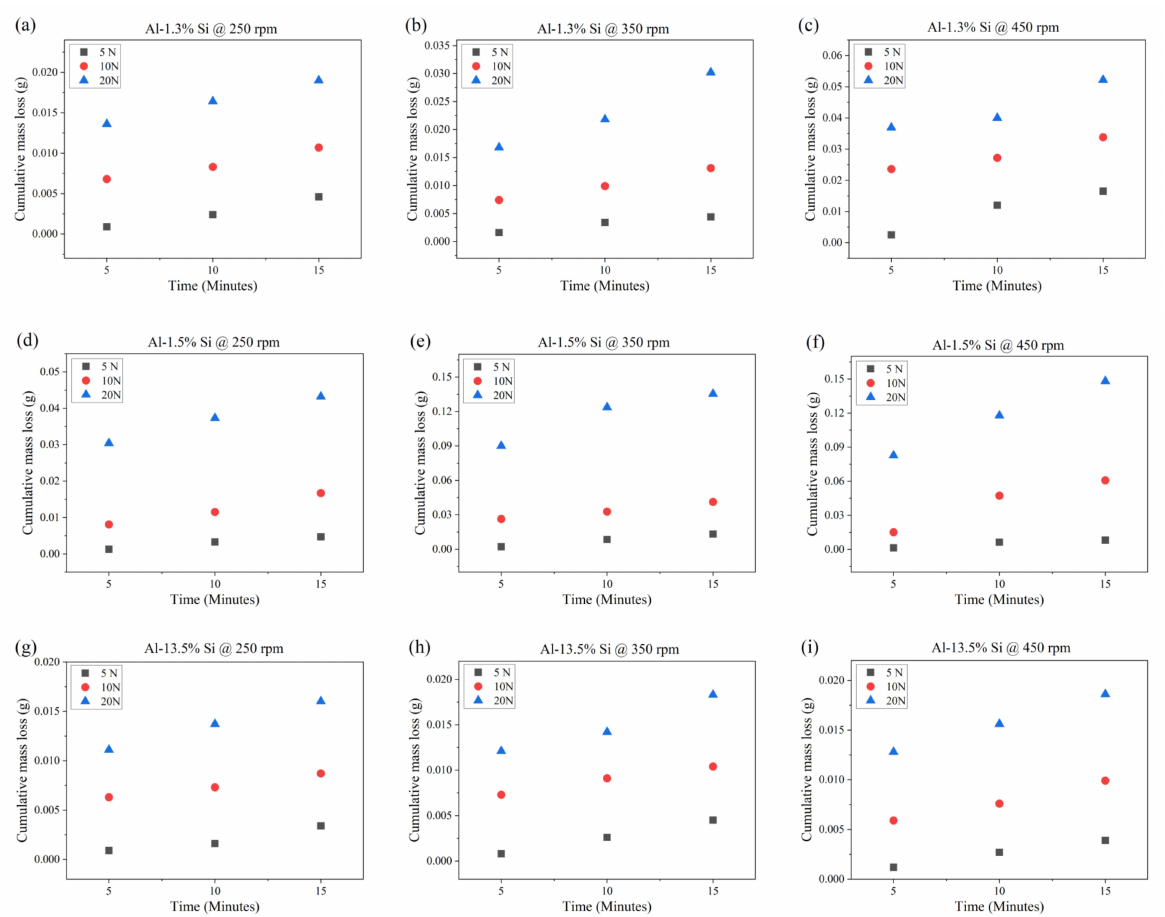
Figure 7. Cumulative mass loss vs. time plots as functions of normal load (5, 10, and 20 N) and rotational speed (250, 350, and 450 rpm) for ( a – c ) Al–1.3%Si; ( d – f ) Al–1.5%Si; and ( g – i ) Al–13.5%Si